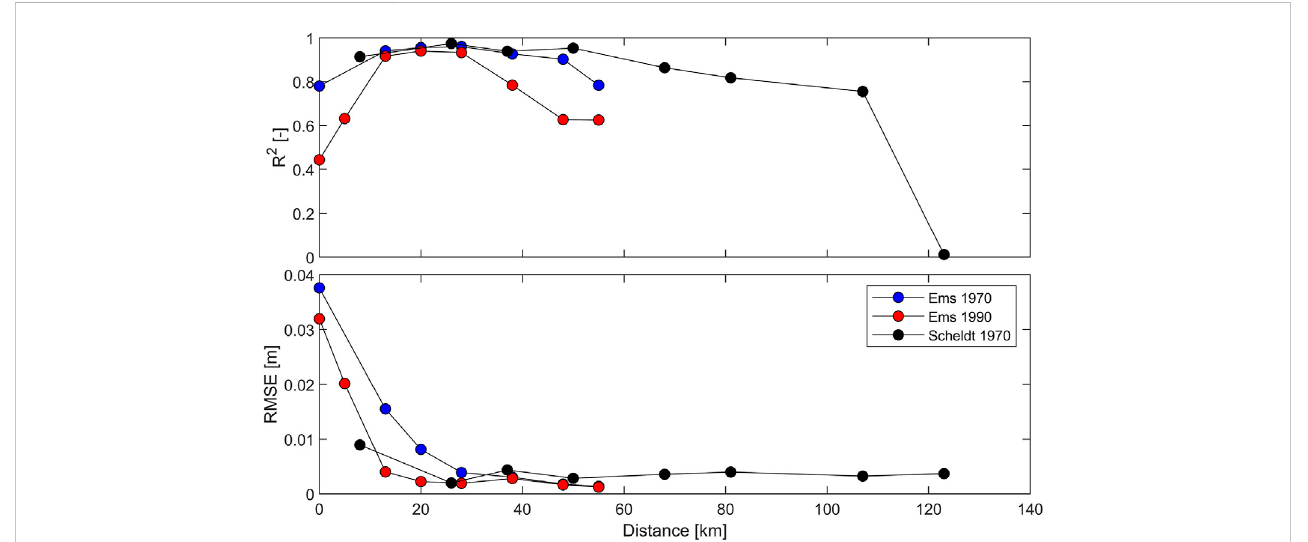
FIGURE 14 R 2 and RMSE for the function fi t in the Scheldt Estuary and for the Ems Estuary starting in 1990 and 1970.